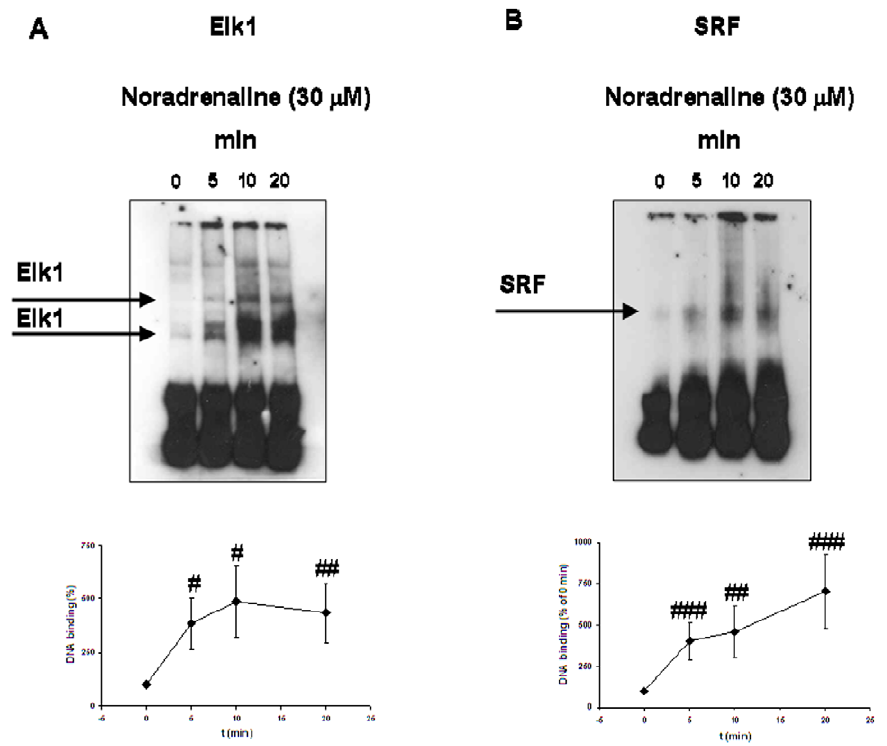
Figure 4. NA-induced Elk1 and SRF activation in human prostate tissue. Prostate tissue from each patient was allocated to four samples, which were stimulated for indicated periods. Despite different stimulation periods, all samples were exposed for identical total periods to experimental conditions to prevent agonist-unspecific effects. Elk1 and SRF activities were asssessed by EMSA. Bands for active transcription factors (bound to DNA probes) were identified using negative controls, and are indicated by arrows. In each experiment, Elk1 or SRF in unstimulated samples (=0 min) was set to 100%, and values for stimulated samples were referred to the unstimulated sample. ( A ) NA-induced Elk1 activation (n=9 patients). ( B ) NA-induced SRF activation (n=9 patients). Shown are representative experiments, and densitometric quantification of all experiments (means 6 SEM).